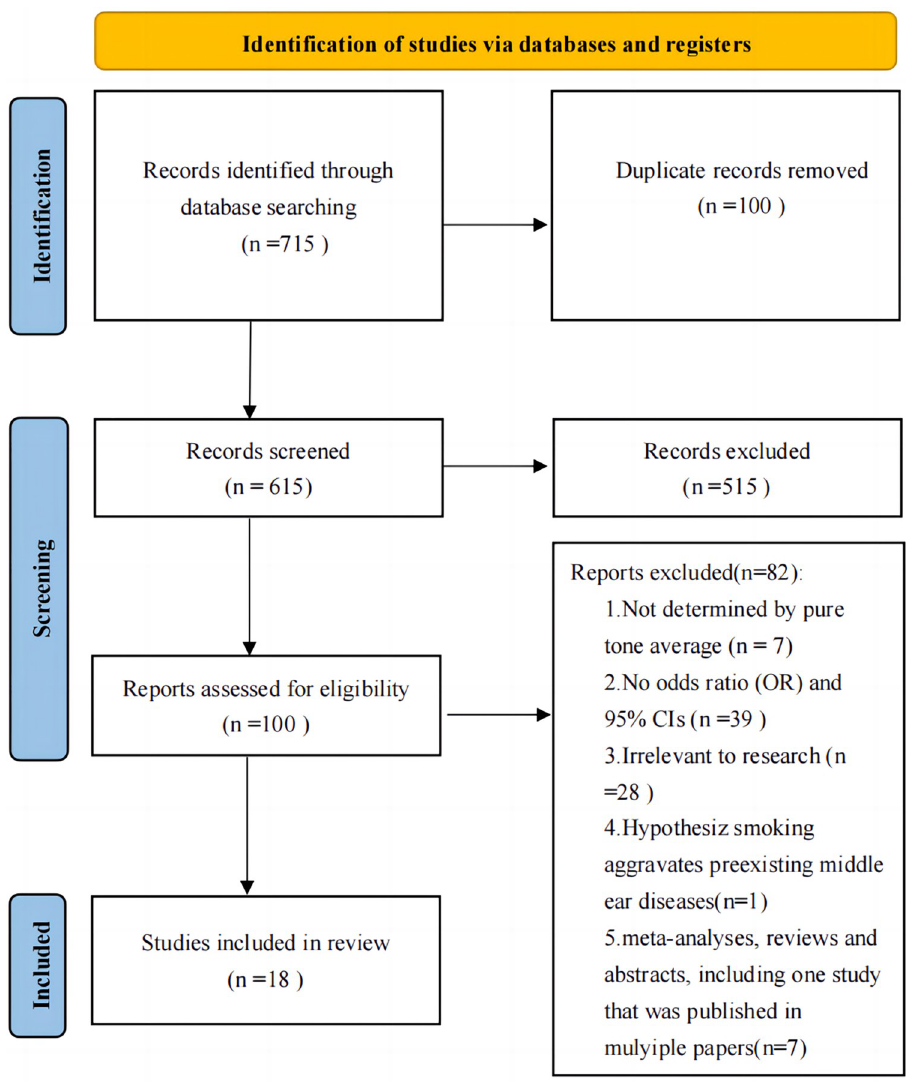
Fig 1. Flow chart of the selection of studies on alcohol consumption and risk of hearing loss included in the systematic review and meta-analysis. Note . Abbreviations: CI, confidence interval; OR, odds ratio.